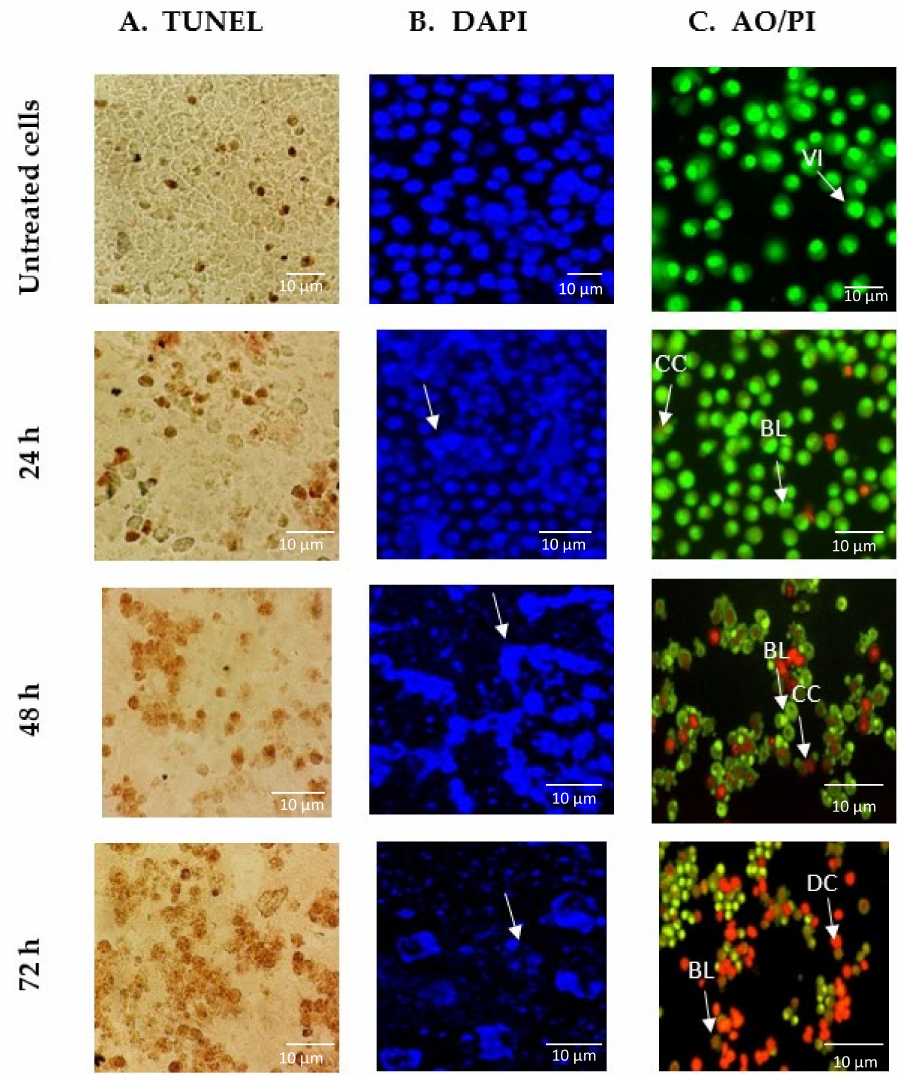
Figure 3. Images of GNST-ITC-induced cell death in MCF-7 cells following incubation for 24, 48, and 72 h. ( A ) Micrograph of TUNEL assay under bright field microscopy with darkened stains indicating DNA fragmentation within the cells. ( B ) Alteration in nuclear morphology of GNST-ITC-treated MCF-7 cells evaluated using DAPI staining with arrows indicating chromatin condensation in the cell nucleus. ( C ) Fluorescence image of MCF-7 cells treated with AO / PI double staining with arrows indicating viable cells (VI), chromatin condensation (CC), membrane blebbing (BL), apoptotic bodies (AB), and dead cells (DC). Results are representative of three independent experiments. Magnification ×